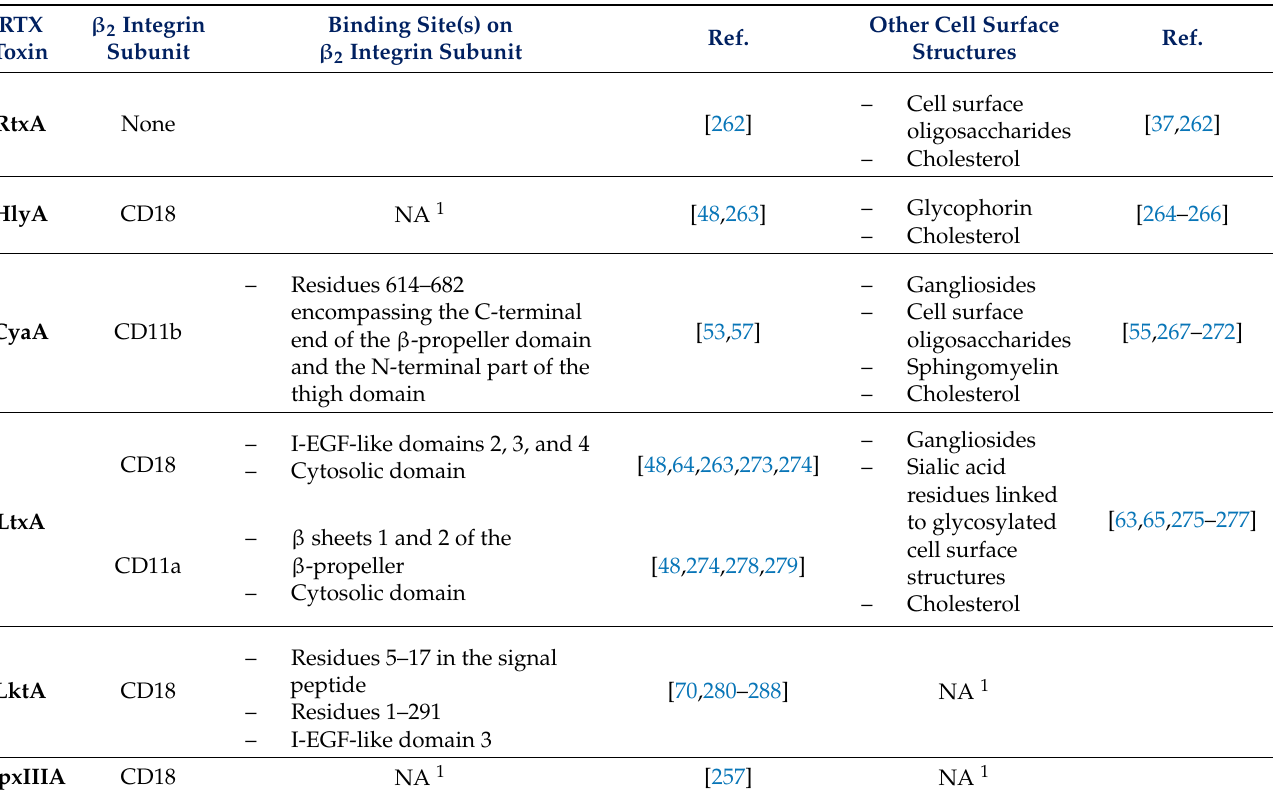
Table 3. Interaction of RTX toxins with host cells via specific β 2 integrin subunits and other cell surface